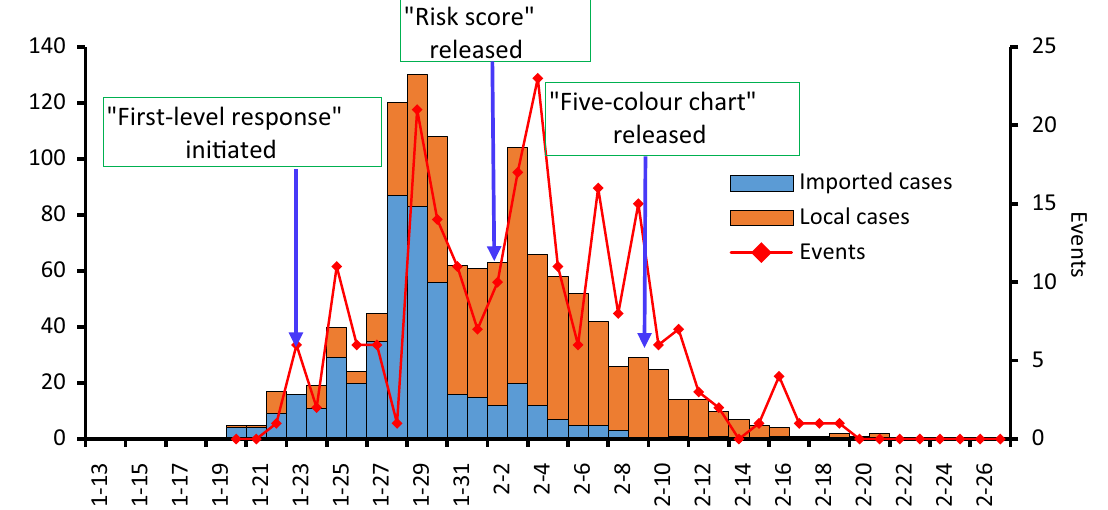
Figure 1. Timeline of the epidemic situation and action for COVID-19 in Zhejiang province of